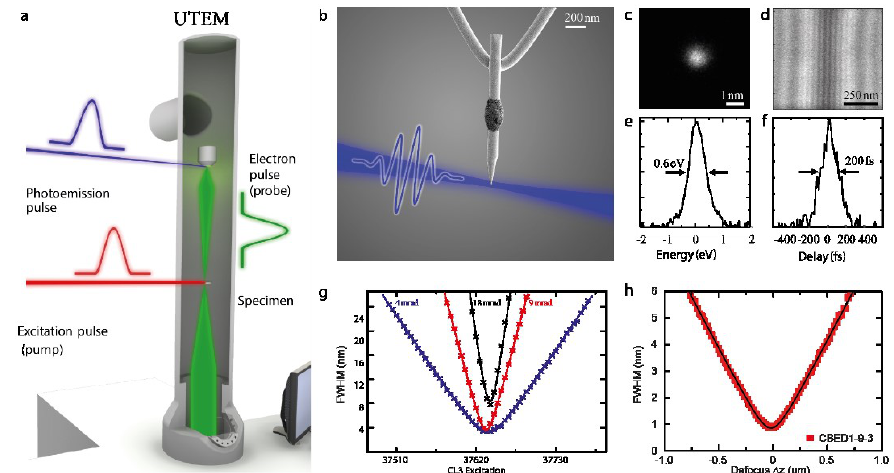
Fig. 1. (a) Schematic of the Göttingen UTEM with stroboscopic laser-pump/electron probe principle. (b) Photoelectron pulses are generated by side illumination of a single-crystalline, (100)-oriented, facetted tungsten tip emitter attached to a heating filament with a ZrO 2 reservoir deposited on the emitter shank. (c,e,f) Currently achievable electron focal spot size, and the spectral and temporal width in a space-charge-free regime. (d) Exemplary photoelectron hologram generated with a Möllenstedt biprism. (Figure adapted from Ref.